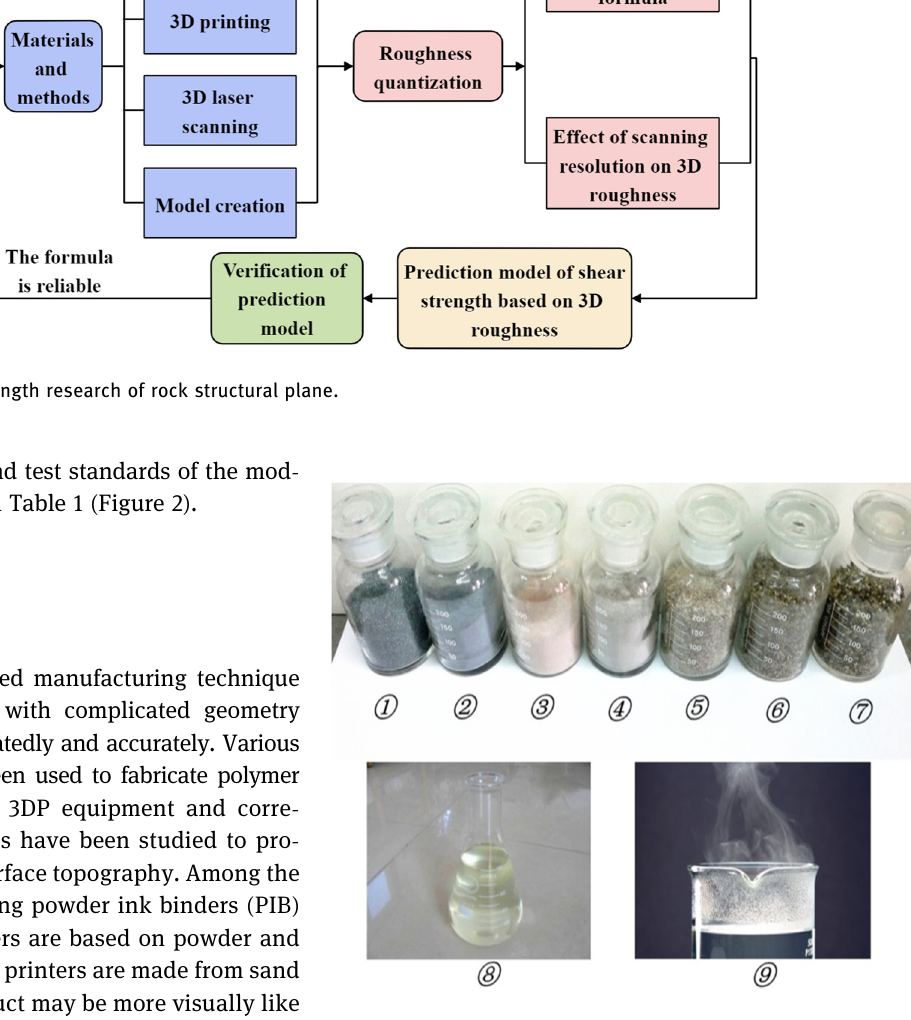
Figure 2: Components of similar raw materials. ① Green SiC, ② Micro silicon powder, ③ Early - strength admixture, ④ Portland cement, ⑤ Fine sand, ⑥ Coarse sand, ⑦ Aggregate ( 3 – 6 mm ) , ⑧ Carboxylic water - reducer, and ⑨ Warm water ( 30 – 45°C )